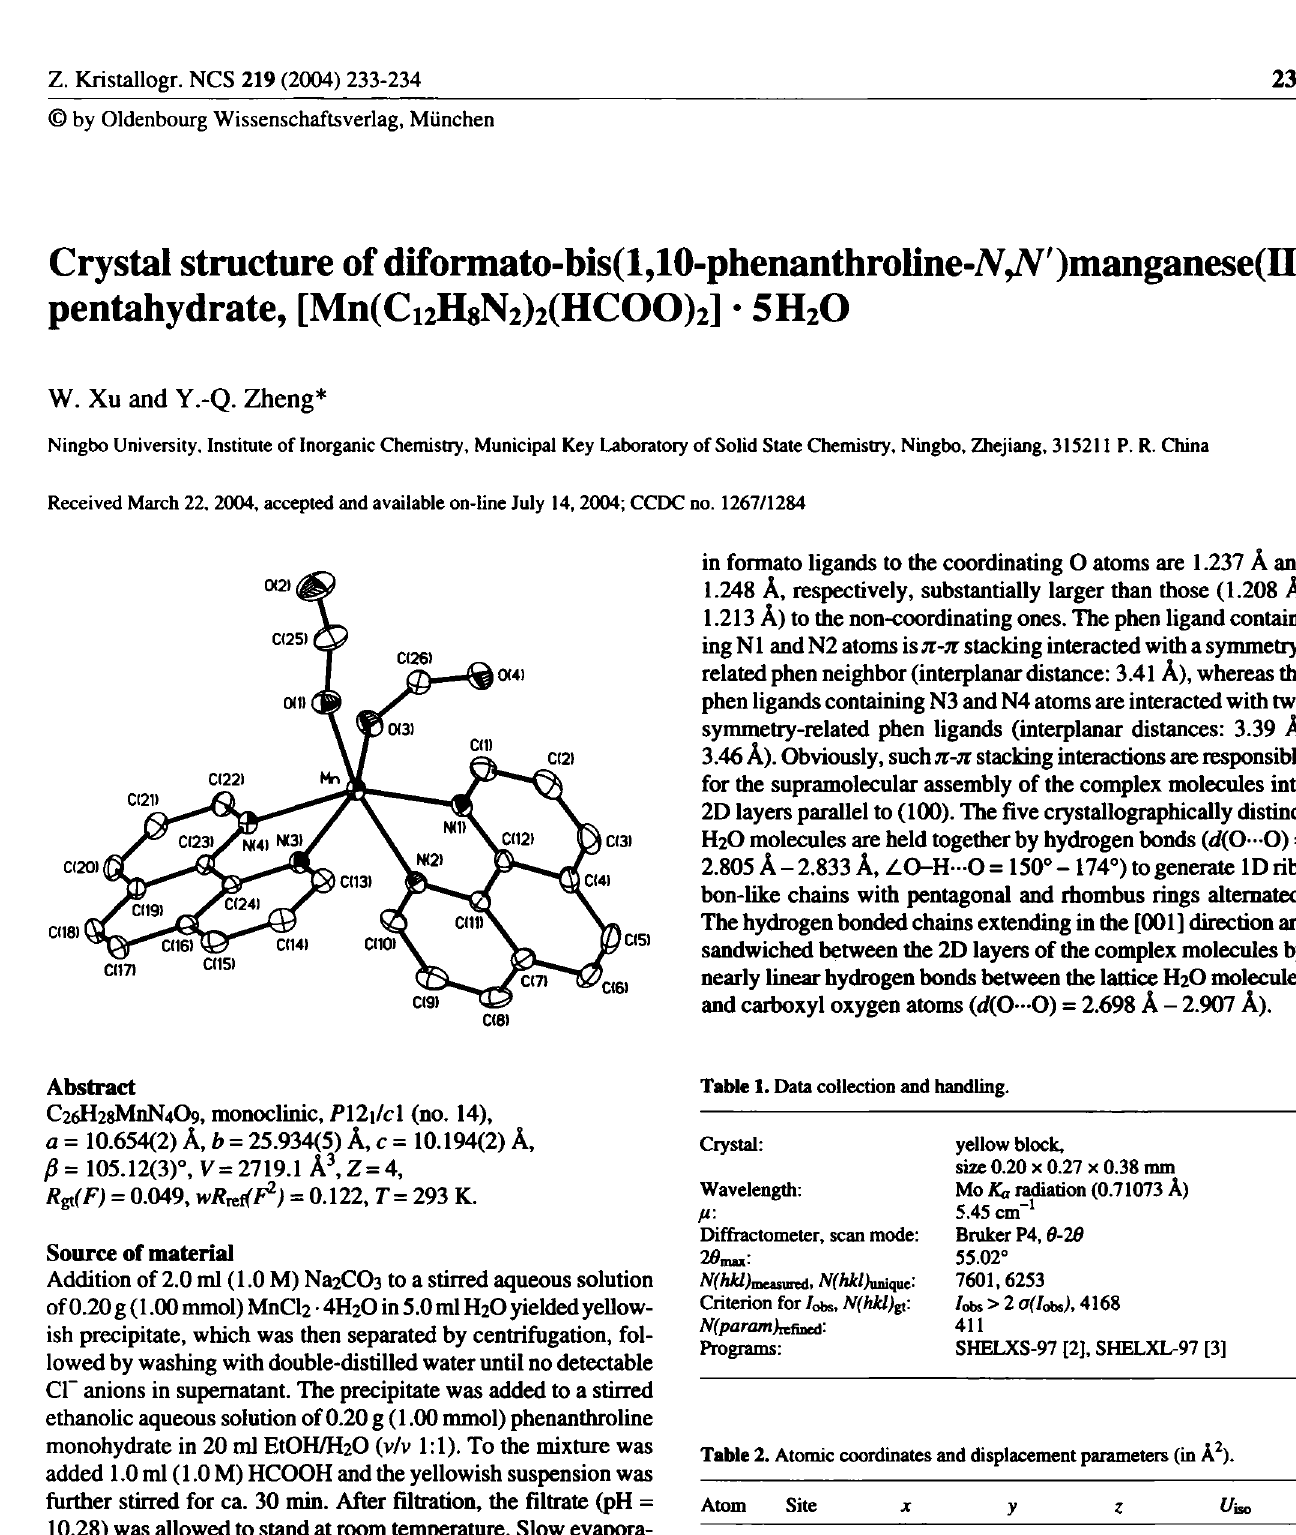
Table 2. Atomic coordinates and displacement parameters (in Â 2